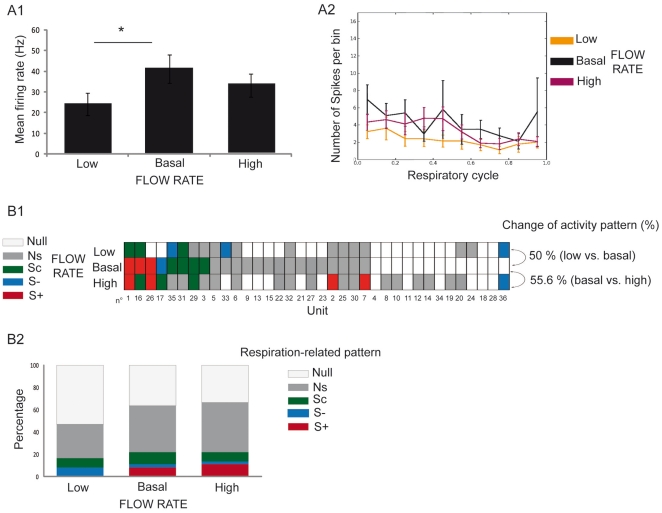
Spontaneous activity of OB units is modified by nasal flow rate.Thirty six mitral cells were recorded under the three flow rate conditions. A1) Mean instantaneous frequency rate (± SEM) under each flow rate condition (n = 36). Paired t-test, *p<0.05. A2) Mean instantaneous frequency (± SEM) as a function of respiratory cycle under the three flow rate conditions (low flow rate: orange, basal flow rate: black, and high flow rate: purple). B1) Matrix representing respiration-related spontaneous patterns of each cell recorded under the three flow rate conditions. Each line represents a flow rate condition, and each column represents a unit. A color was attributed to each pattern: excitatory synchronized (S+, red), suppressive synchronized (S−, blue), complex synchronized (Sc, green), respiration non-related (NS, gray) and null activity (NULL, light gray). Cells are ordered according to their respiratory-related pattern at basal flow rate. The percent of change in activity pattern represents the percent of units exhibiting a different pattern under the two flow rate conditions B2). Percentages of each spontaneous activity pattern as a function of flow rate condition (n = 36). Low and high nasal flow rate conditions were compared to the basal flow rate. Statistical test: Chi2.